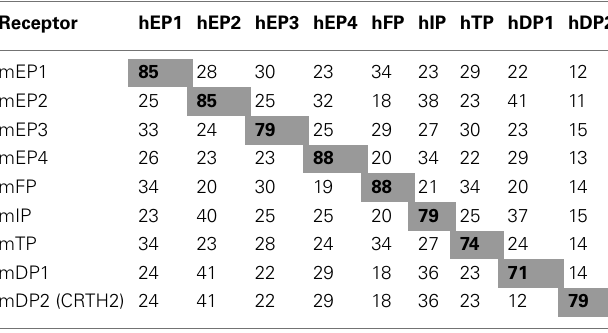
Table 1 |Amino acid homology (% identity) between human (h) and mouse (m) prostaglandin receptors.